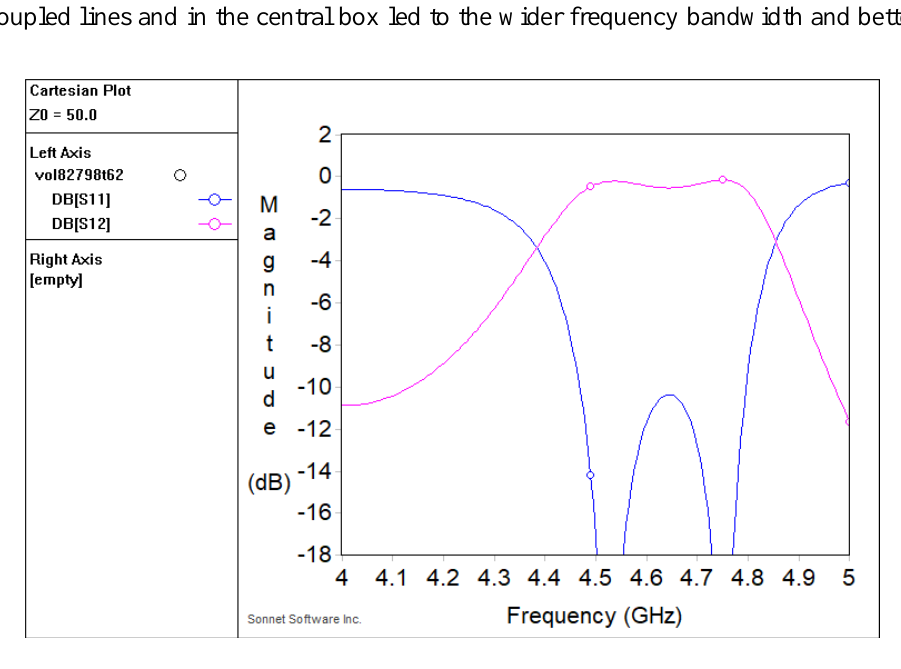
Figure 9. Simulation results